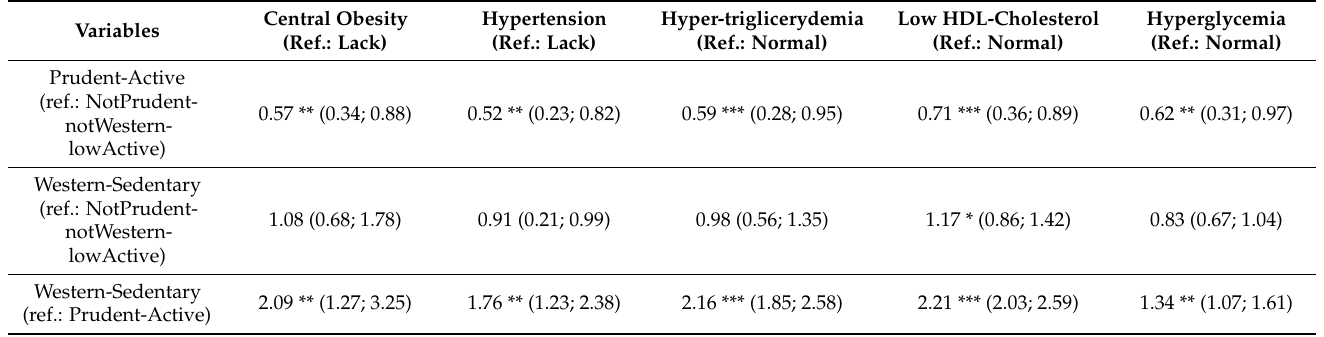
Table 5. Odds ratio (95% confidence interval) for dietary-lifestyle patterns by metabolic syndrome